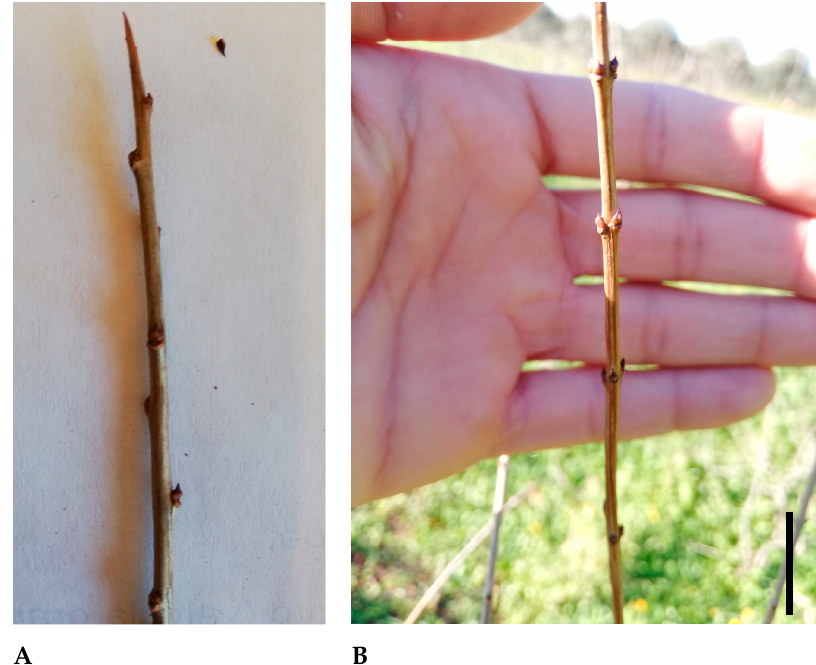
Figure 6. A single bud at each node for Ki-Zakuro ( A ) and more buds (3) per node for Haku Botan ( B ). The scale bar represents 2 cm.